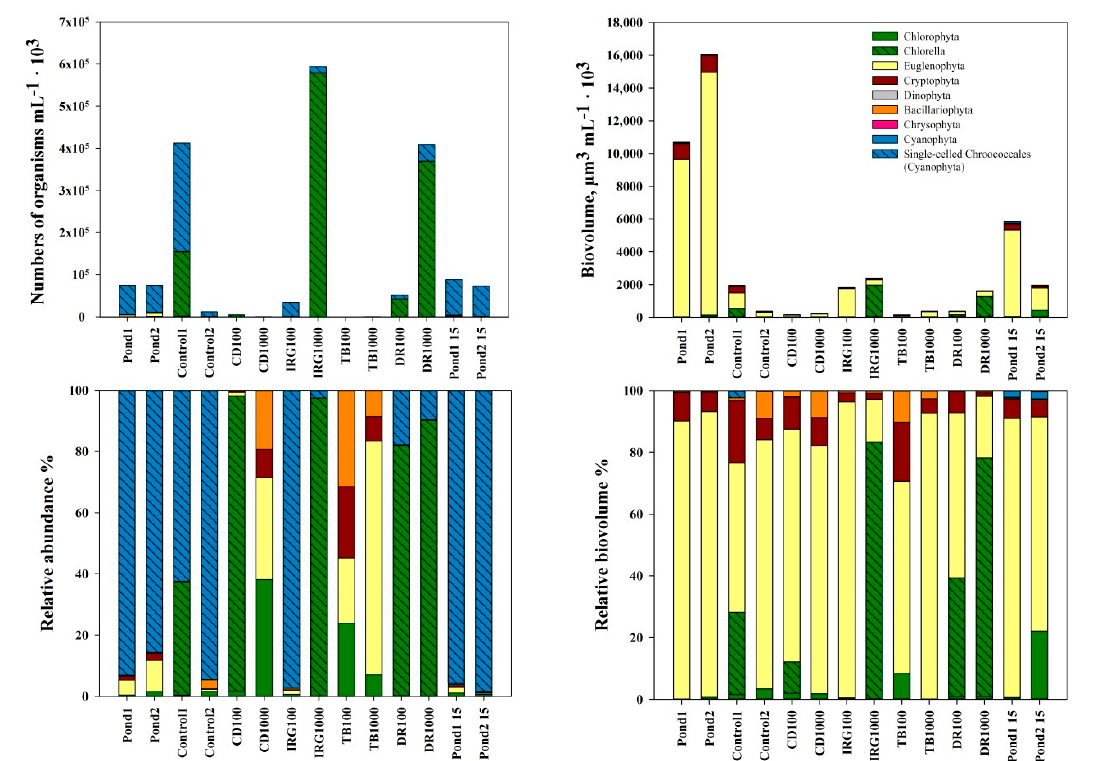
Figure 4. Phytoplankton taxa distribution in the in situ mesocosm study. Absolute and relative values are given for the counted numbers of organisms and the estimated biovolumes.